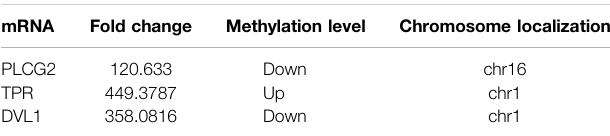
TABLE 6 | Initial detection of methylation of three